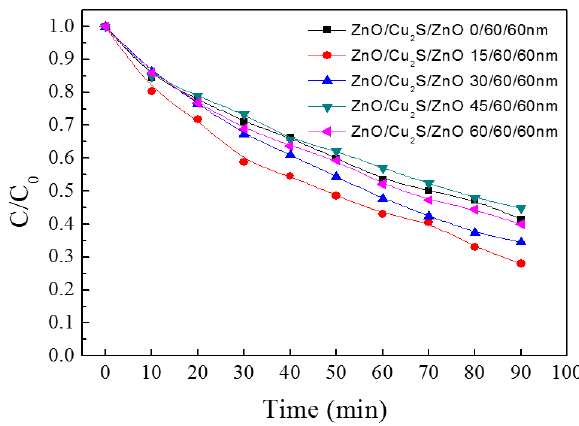
Figure 27. The photocatalytic activity of ZnO/Cu 2 S/ZnO/glass complex films for different.